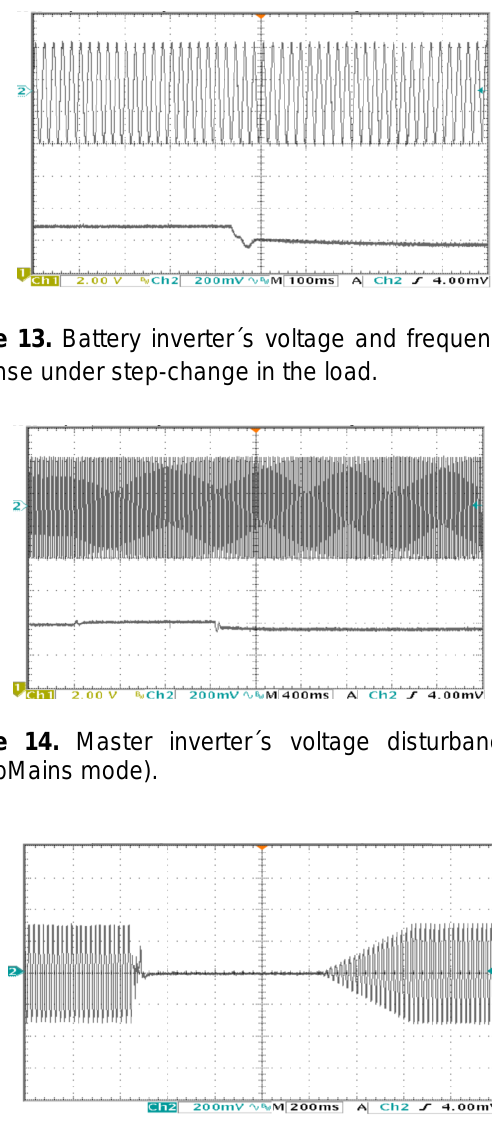
Figure 15. Master inverter´s voltage disturbance (Fast Mains